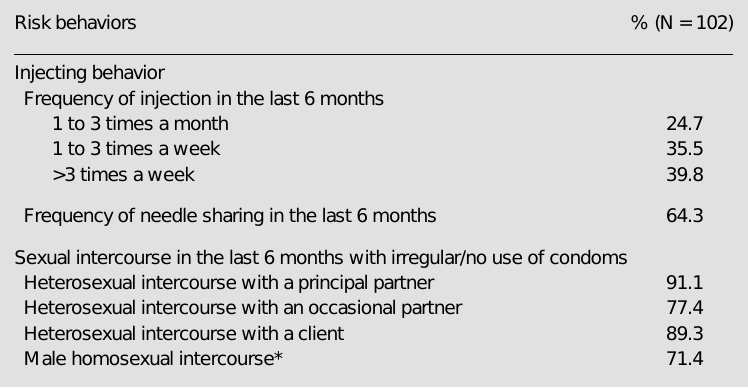
Table 1 - Injecting and sexual risk behaviors among IDUs from Rio de Janeiro, Brazil